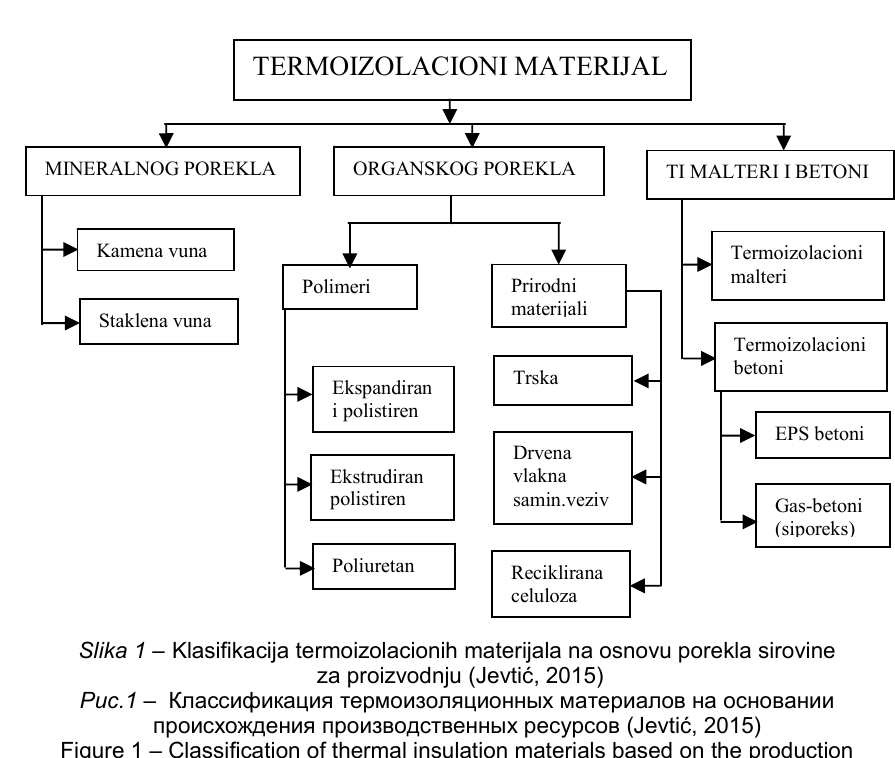
masi i mestu i na č inu primene.